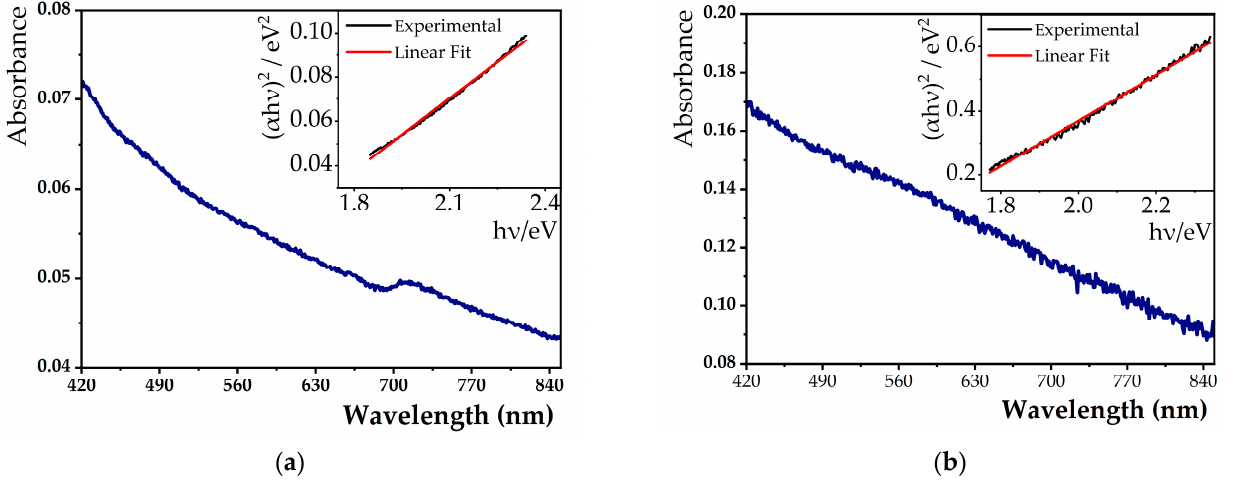
Figure 1. Absorption spectra of 0.2 mM aqueous solutions of non-calcined ( a ) and calcined ( b ) Mg 0.75 Ca 0.25 Fe 2 O 4 nanoparticles, using ultrapure water as a reference. Inset: Tauc plot fitted to the experimental data.